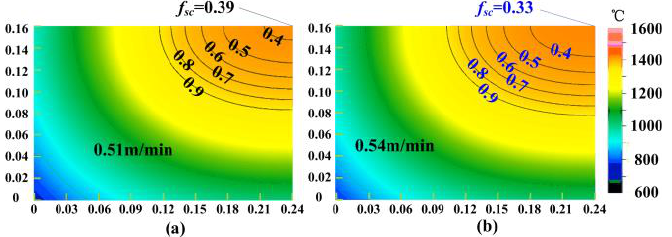
Figure 12. Solid fraction at the middle of FEMS: ( a ) before optimization; ( b ) after optimization.